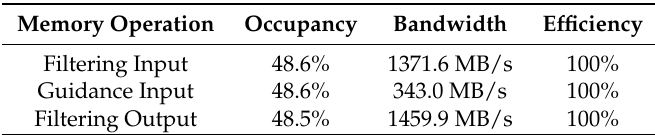
Table 5. Profiling results when executing the sliding window implementation of the guided image filter